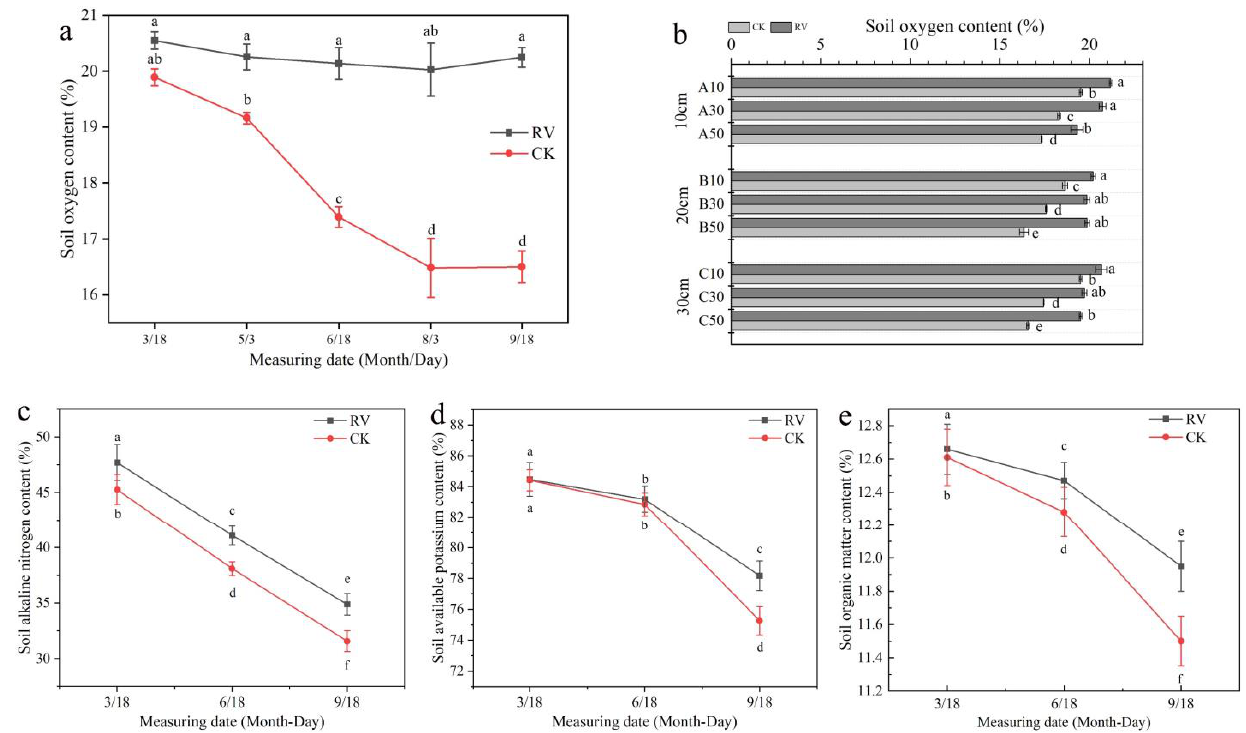
Figure 2. Effects of root-zone aeration on the soil oxygen content and soil nutrient content: ( a ) The soil oxygen contents at horizontal distances of 20 cm from the aerator and vertical depths of 30 cm from the ground at different times. ( b ) The soil oxygen contents at horizontal distances of 10, 20, and 30 cm from the aerator and vertical depths of 10, 30, and 50 cm from the ground; A, B, and C represent the horizontal distances of 10, 20, and 30 cm from the aerator, respectively. ( c ) Soil alkali-hydrolyzable nitrogen content. ( d ) Soil available potassium content. ( e ) Soil organic matter content. RV: root-zone aeration treatment; CK: non-aeration as a control. Each point represents the mean ± standard error ( n = 3). Different lowercase letters indicate significant differences between treatments ( p < 5%, two-way ANOVA).